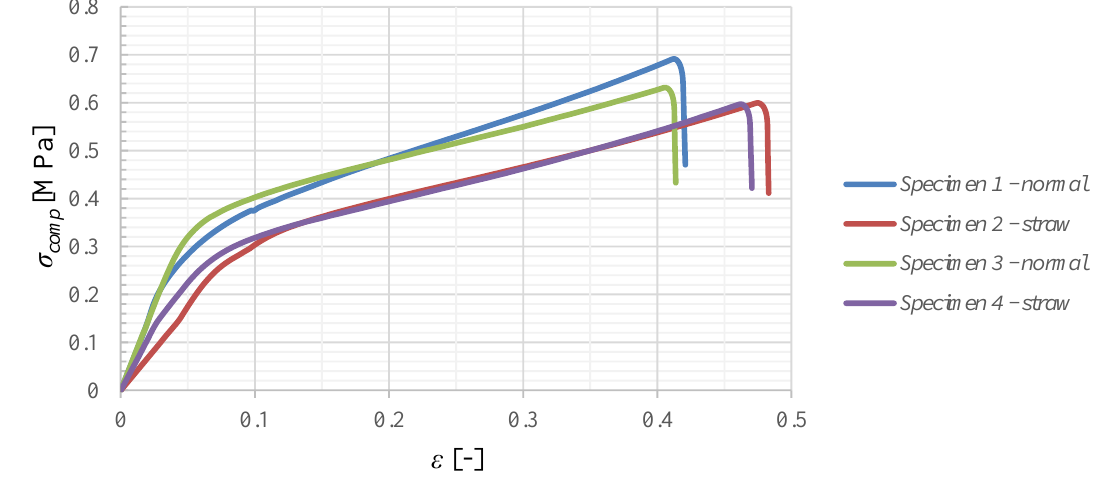
Figure 9. Measured results of normal and straw reinforced polystyrene.